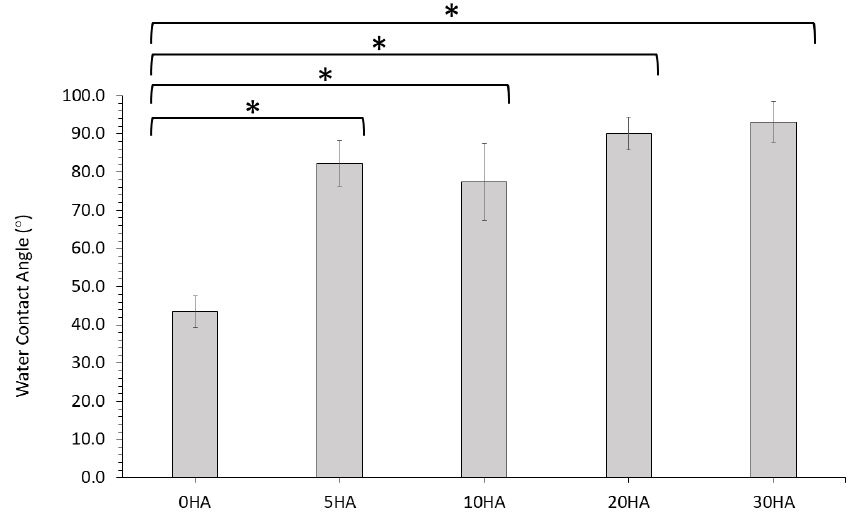
Figure 11. Water Contact Angle of the 3D printed samples (°). N=6 for each sample type. Error bars represent standard deviation. (*— p < 0.05).